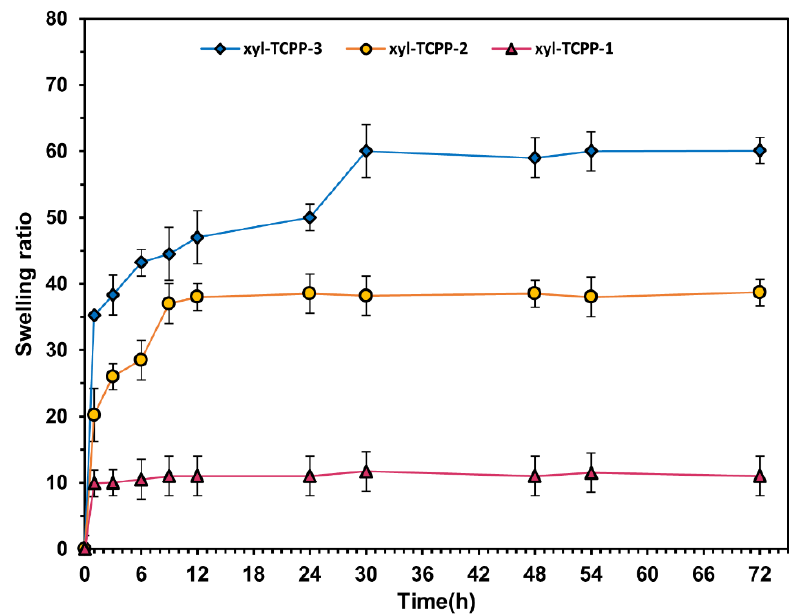
Figure 5. Time course of swelling ratios of xyl-TCPP-1, xyl-TCPP-2, and xyl-TCPP-3 in PBS.